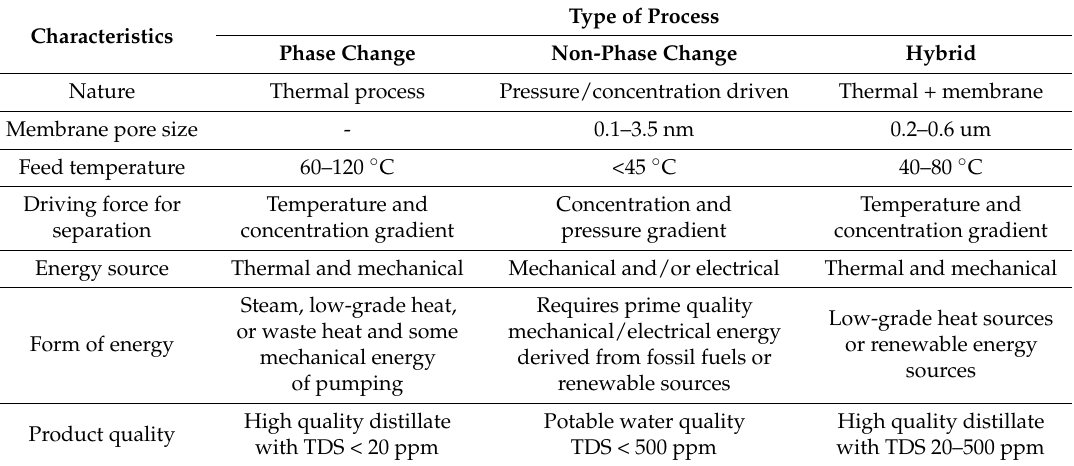
Table 1. Principal characteristics of different desalination